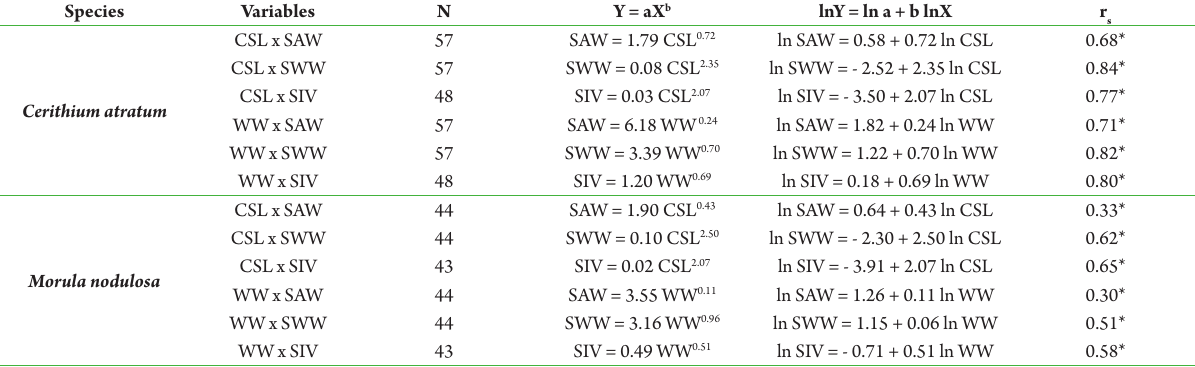
Table 4. Pagurus criniticornis . Regression analysis for each chosen shell size (CSL = Cephalothoracic Shield Length; WW = hermit crab Wet Weight; SAW = Shell Aperture Width; SWW = Shell Wet Weight; SIV = Shell Internal Volume; N = number of individuals; r = Spearman correlation s